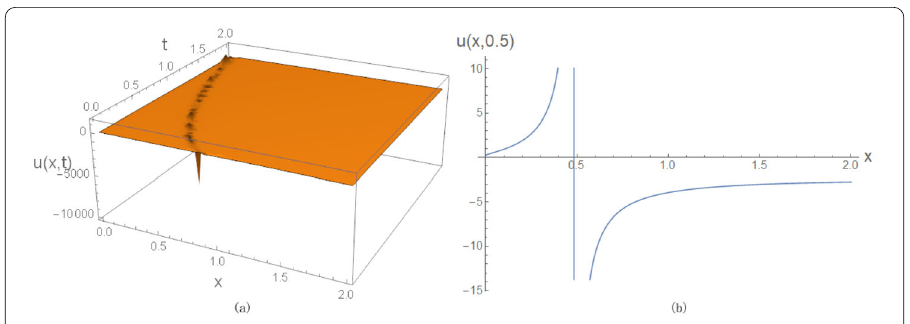
, and ξ 0 = 1; ( b ) the corresponding 2